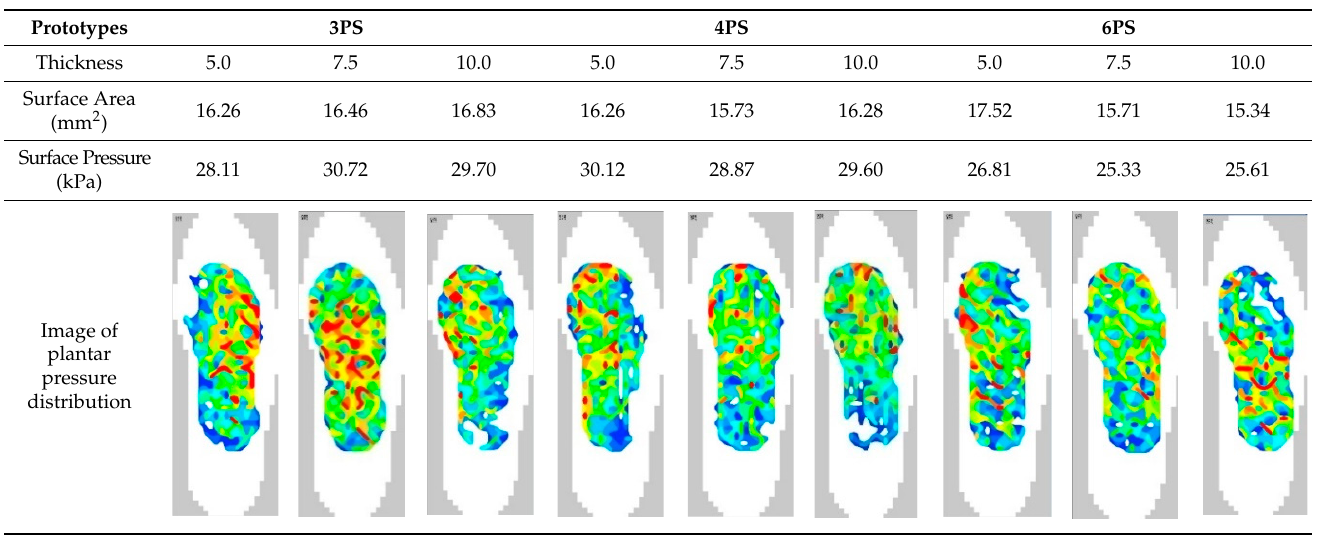
Table 5. The surface area and surface pressure of the LW 3DP 3-, 4-, and 6-PS outsole were measured by an insole sensor tester.